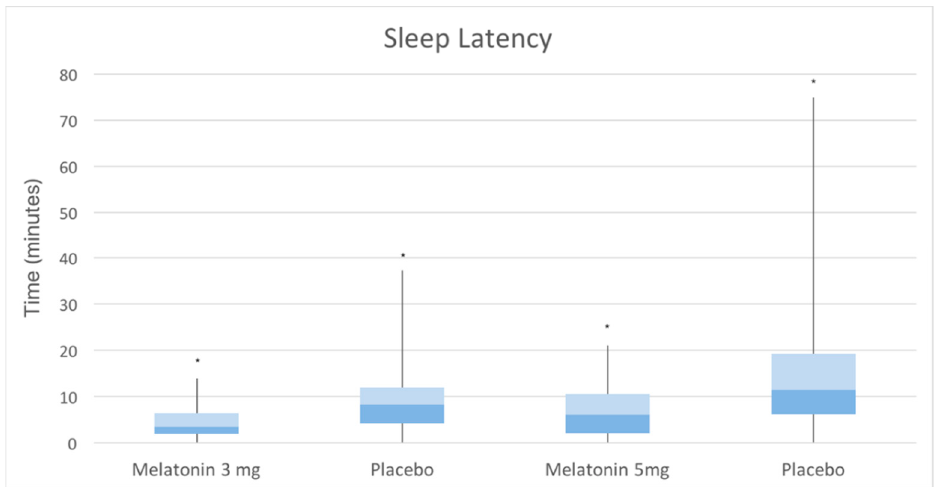
Figure 2. Box plot showing different sleep latencies in MG at different doses and CG. * p- value 3 mg vs. placebo: 0.04; 5mg vs. placebo: 0.03.